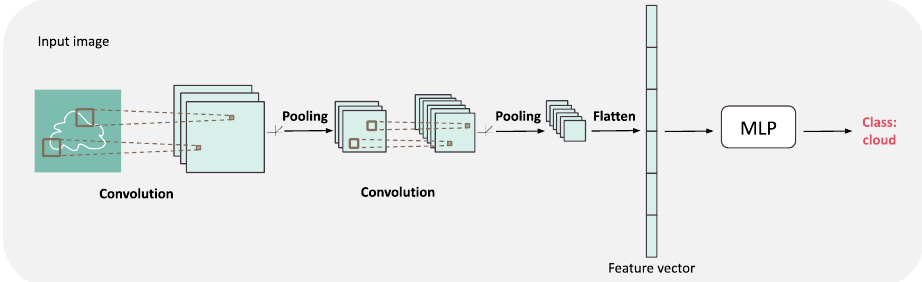
Figure 3. Convolutional neural network (CNN) architecture. The architecture is composed of a succession of convolutions, followed by an activation function and pooling layers to extract more and more global features from the image. Then, these features are flattened into a vector fed into a usual MLP which output is directly used to predict the class or regression